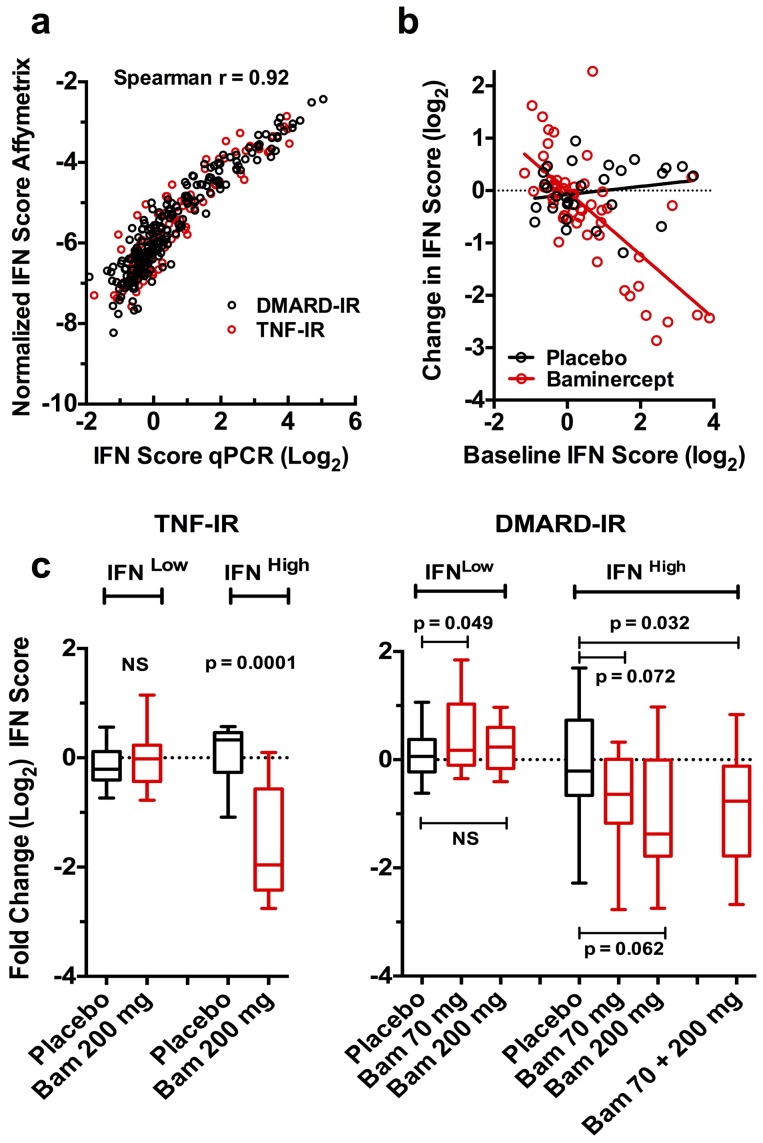
Blockade of the lymphotoxin-LIGHT pathway with baminercept reduces the blood RNA IFN signature in RA patients.a). Analysis of the individual baseline IFN scores as determined using the 15 gene microarray data and a three-gene qPCR score showing excellent correlation. b). Analysis of the change in the 3-gene qPCR IFN score as a function of baseline IFN score following 14 weeks of treatment with 200 mg baminercept q2w in TNF-IR patients, significance is calculated using a linear model of change in IFN score as an interaction of baseline IFN score and treatment (placebo or baminercept). The significance for baseline IFN is p = 2×10−7 and for the interaction term p = 2.3×10−7. Treatment alone is marginally significant p = 0.0506. c). Change in the qPCR-based IFN score at 14 weeks in patients with low vs. high baseline IFN scores (low <1, high >1). Red boxes represent baminercept (Bam) treated patients receiving either 70 or 200 mg q2w (DMARD-IR) or 200 mg q2w (TNF-IR) while black boxes indicate placebo treated patients; n = 20, 50, 11 and 12 (TNF-IR) and 49, 44, 50, 20, 28, 18 and 38 (DMARD-IR) patients in each category in the order listed. P values are from a Mann-Whitney test of placebo vs. baminercept treated patients.